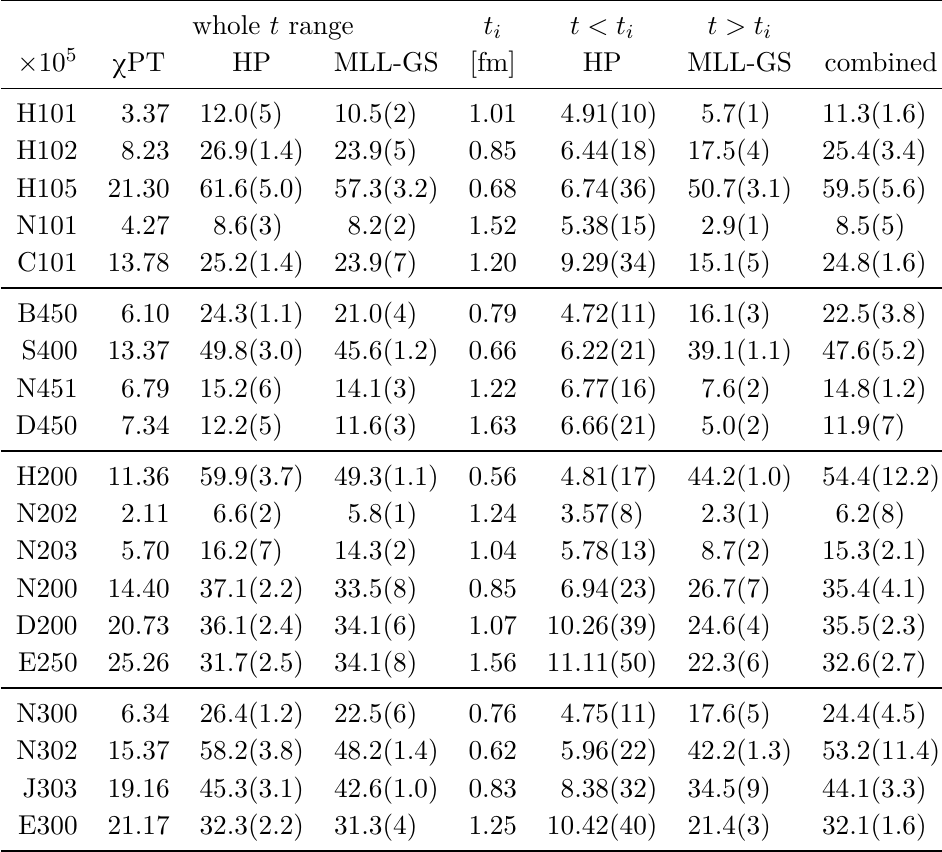
Table 3 . Finite-size corrections to the I = 1 HVP function ¯ Π 33 ( − Q 2 ) × 10 5 at Q 2 = 1 GeV 2 for each individual gauge ensemble. Columns 2 – 4 show the finite-size effects estimated using NLO q